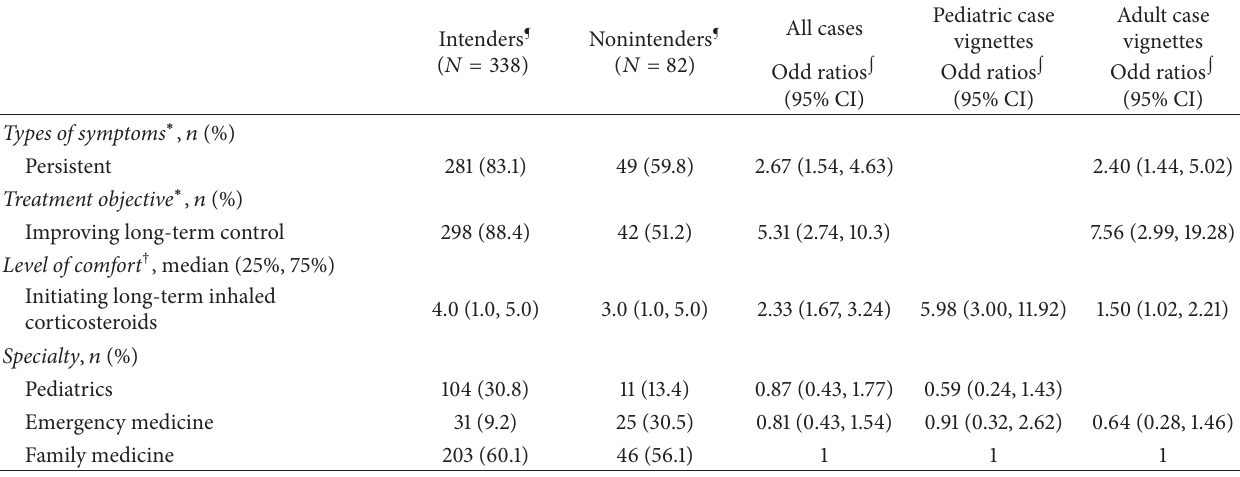
Table 2: Multivariate analysis of intention of prescribing long-term asthma controller.